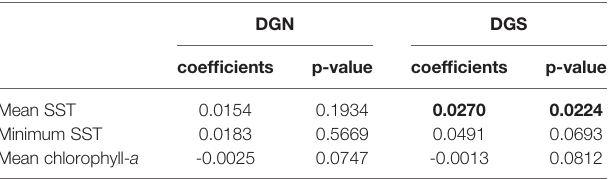
Bold fonts are relationships that corresponding p-values are less than